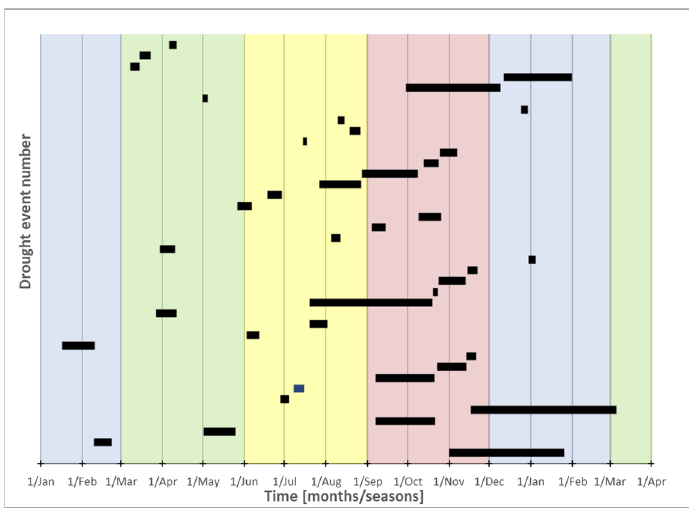
Figure 3. Occurrence and duration of drought episodes.